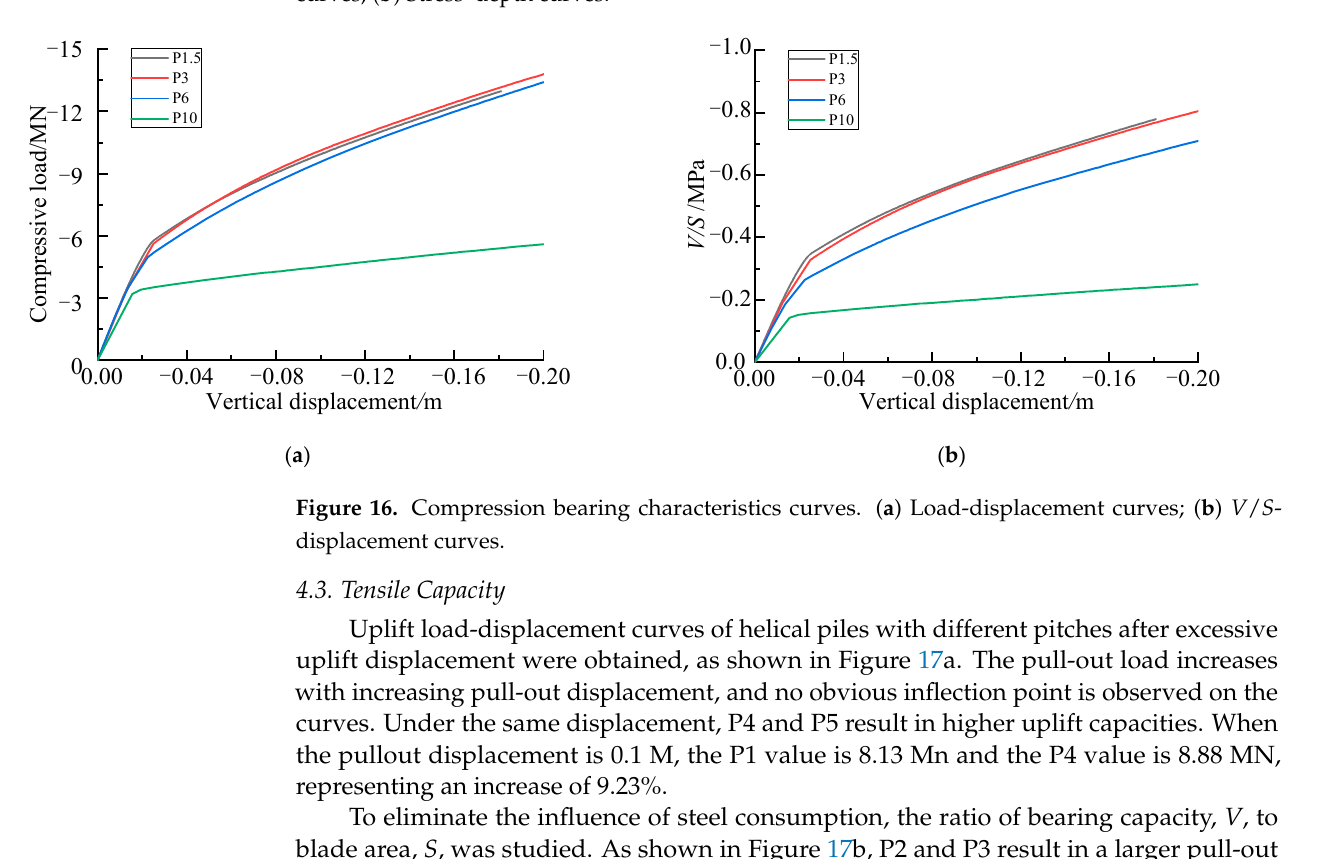
Figure 16. Compression bearing characteristics curves. ( a ) Load-displacement curves; ( b ) V/S -dis- placement curves.